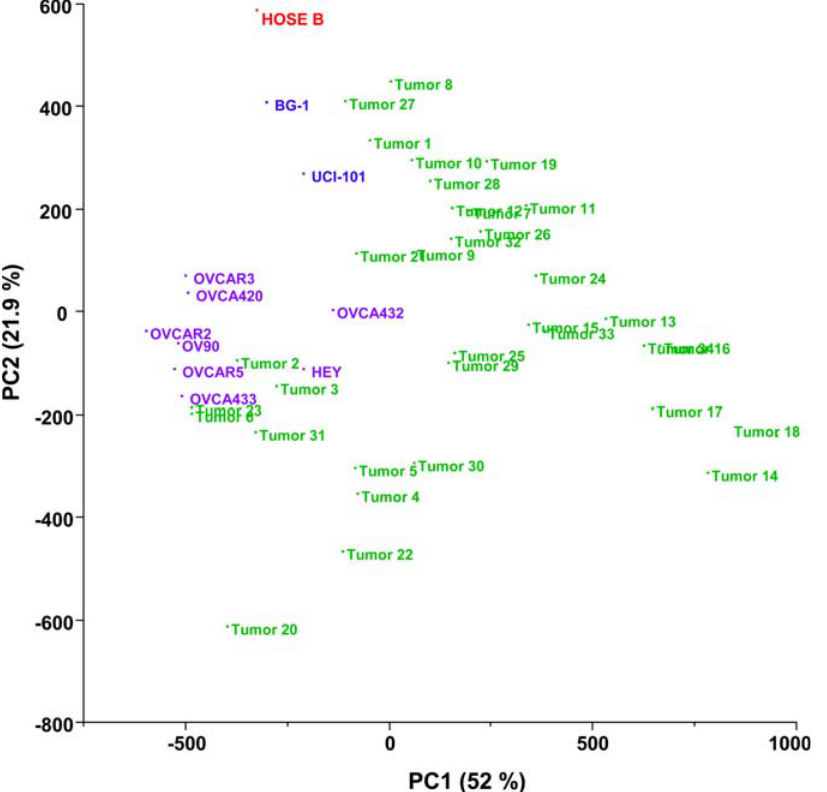
Figure 2. Principal component analysis of ovarian cancer samples (PCA) based on global miRNA expression. Two-dimensional PCA shows that global miRNA expression patterns are different in ovarian cancer cell lines (indicated in blue), ovarian cancer tissues (indicated in green), and the non-tumorigenic HOSE-B cells (in red).